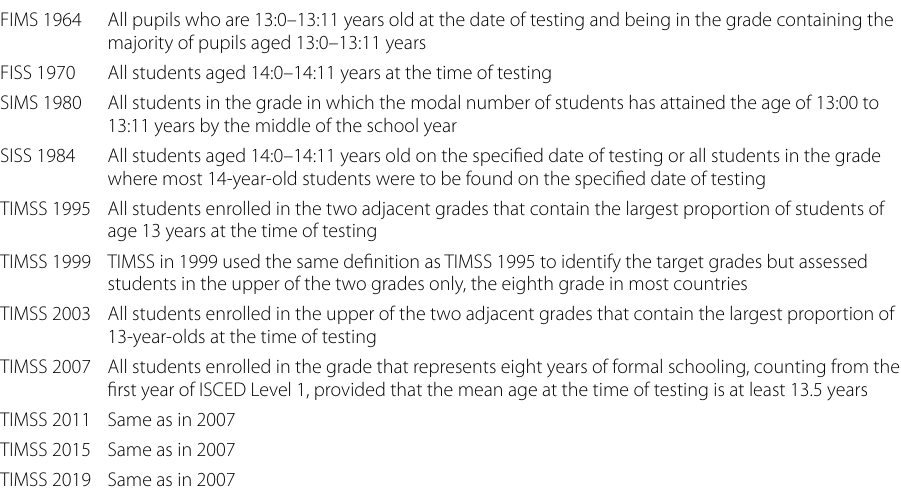
Table 4 Target population definitions of the respective studies FIMS